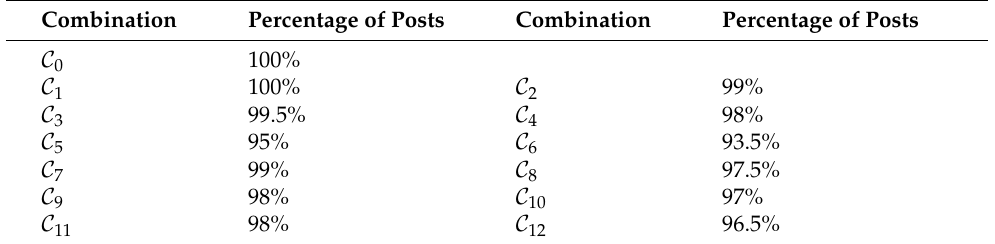
Table 8. Percentage of posts returned by our approach that the human expert evaluated to have high eWoM Power in